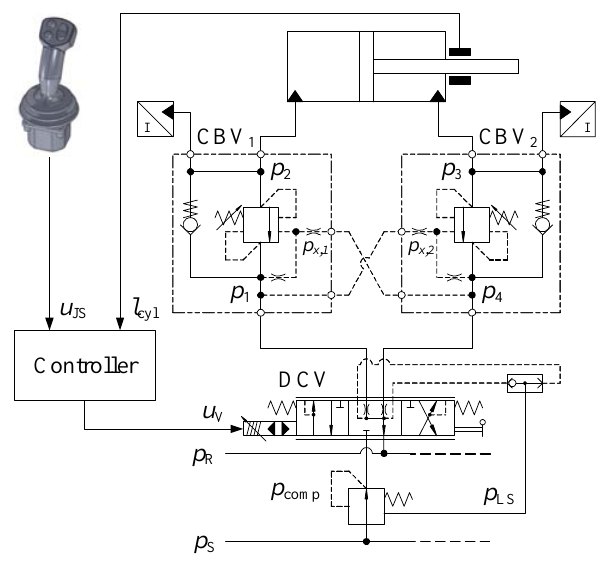
Figure 3: Simplified schematic of motion control sub- system for intermediate and outer jibs.